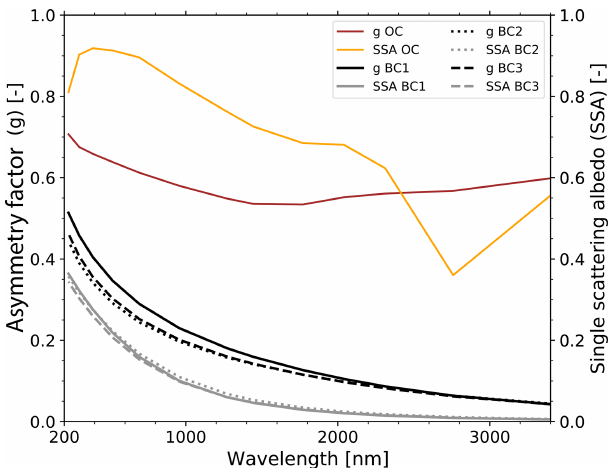
Figure 4. Optical properties of wildfire smoke. Asymmetry factor g and single-scattering albedo SSA of OC (orange, brown) and for three different BC parameterizations (BC1, BC2, BC3) used in the ECRAD simulations.